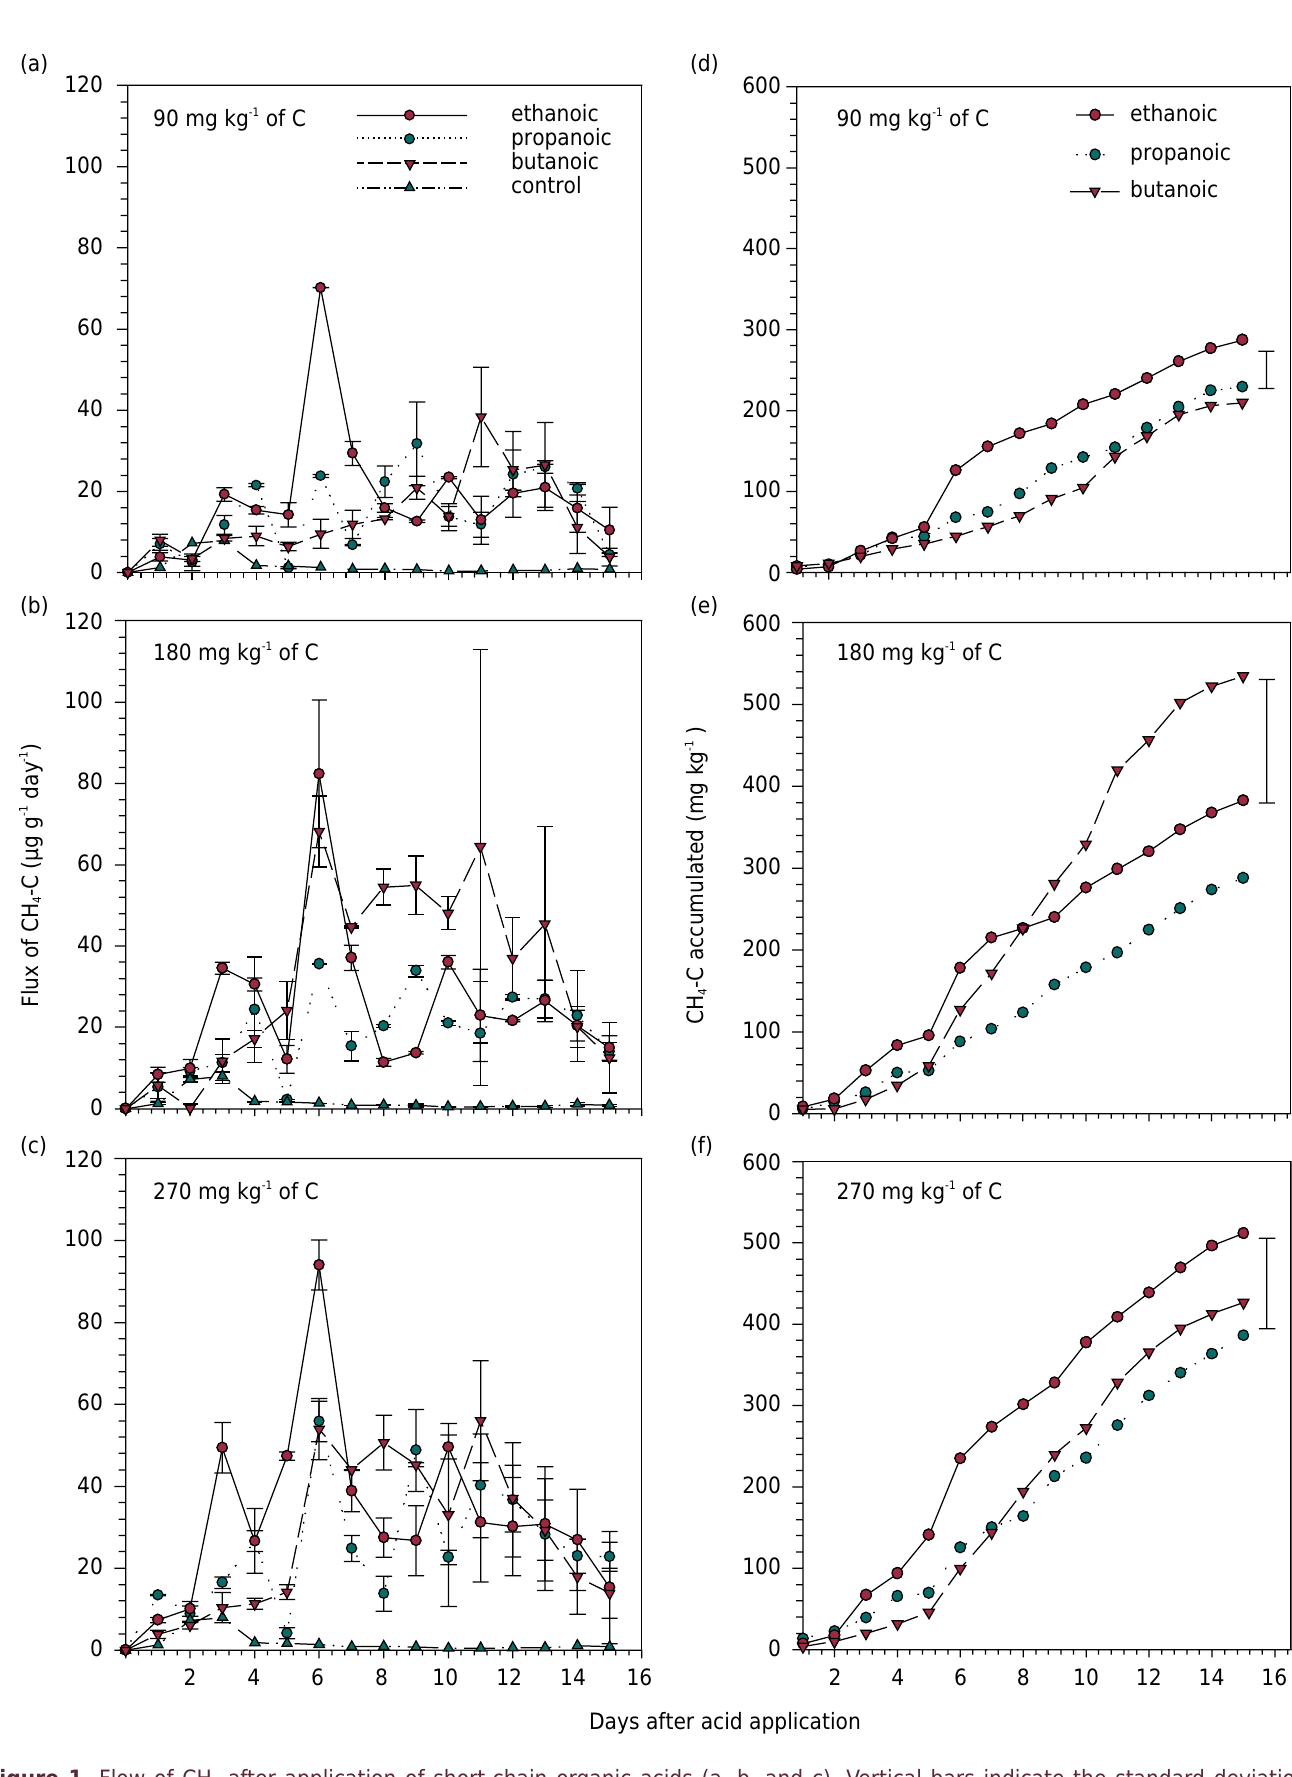
Figure 1. Flow of CH 4 after application of short-chain organic acids (a, b, and c). Vertical bars indicate the standard deviation. Accumulated net emission of CH 4 after application of short-chain organic acids (d, e, and f). The vertical bars indicate a significant difference between the means of the treatments using Tukey’s test